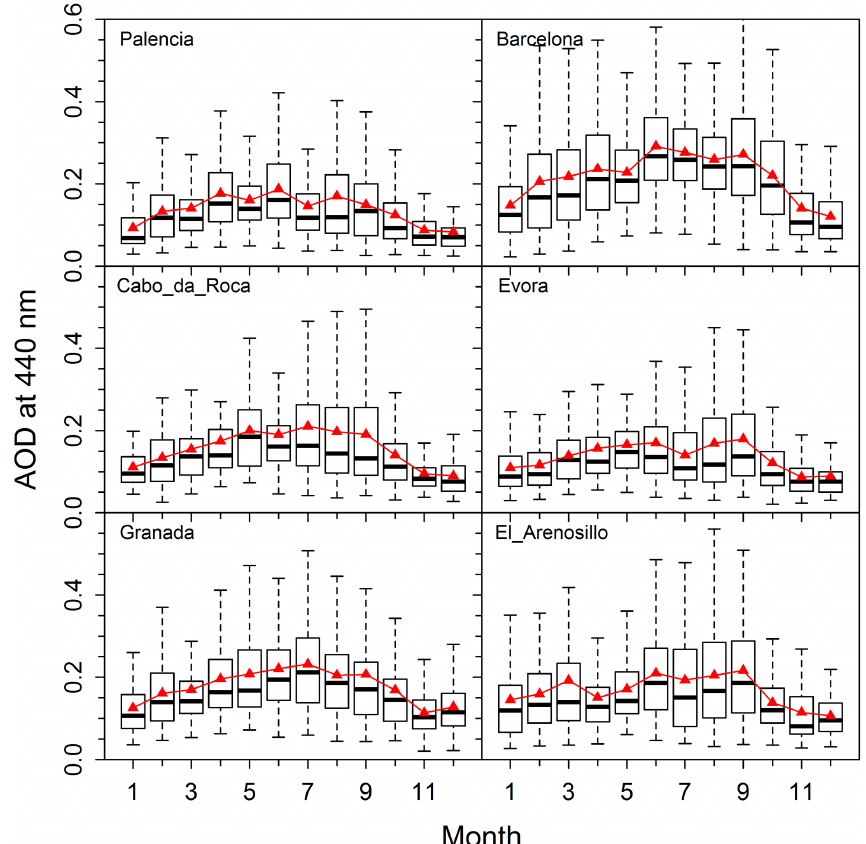
Figure 1. Annual cycle of daily values of AOD at 440nm in box whisker plots for the six sites studied. Triangles and horizontal solid lines indicate the monthly average and median values,